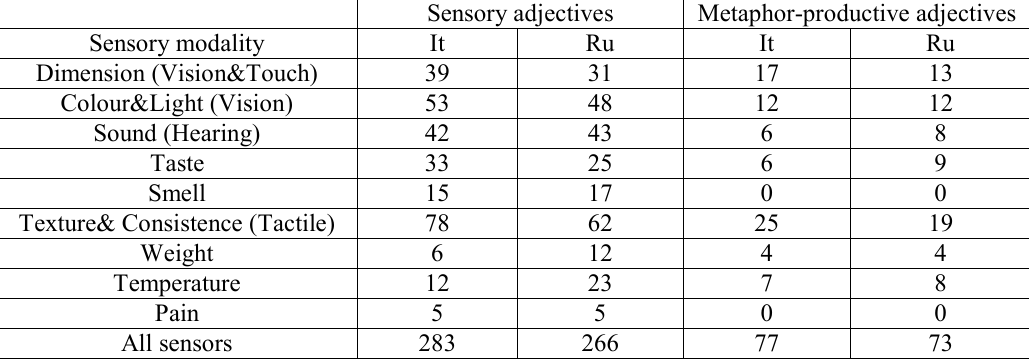
Table 1. – Total number of studied sensory adjectives, metaphor-productive